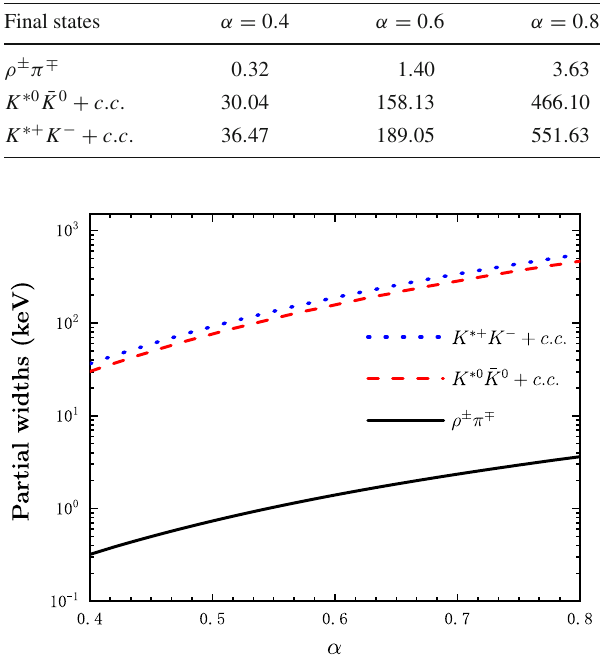
→ V P with m χ (cid:2) = c 2 c 2